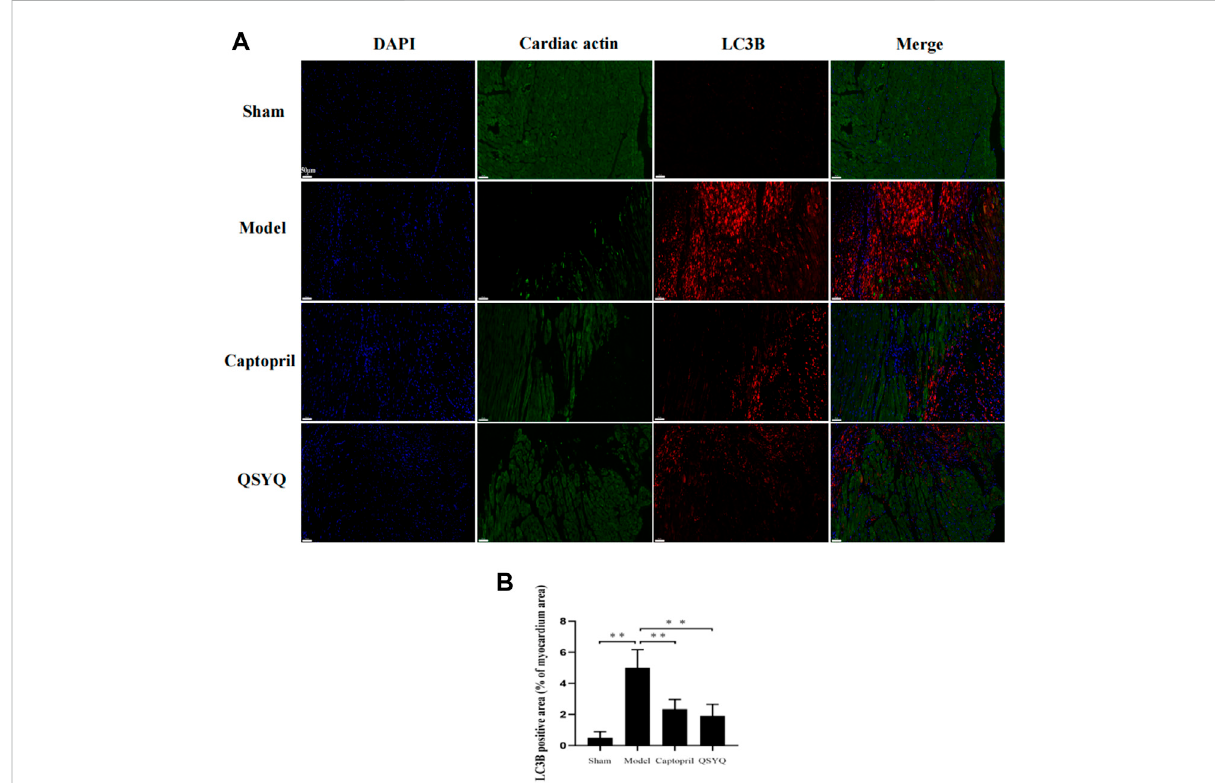
FIGURE 11 Effect of QSYQ on myocardial autophagy-related proteins. (A) : immuno fl uorescence staining showed: LC3B signi fi cantly increased in model group. After treatment with captopril or QSYQ, the expression of LC3B signi fi cantly decreased (Magni fi cation, × 200). (B) : quantitative analysis of LC3B expression in myocardium, n = 4 per group. Data are expressed as mean ± SD. ** p <